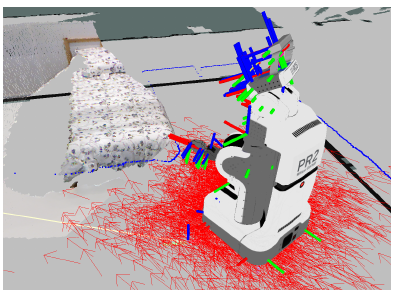
Figure 5. Visualization of a PR2 robot with its coordinate frames and the point cloud from the scene transformed to the world reference frame.